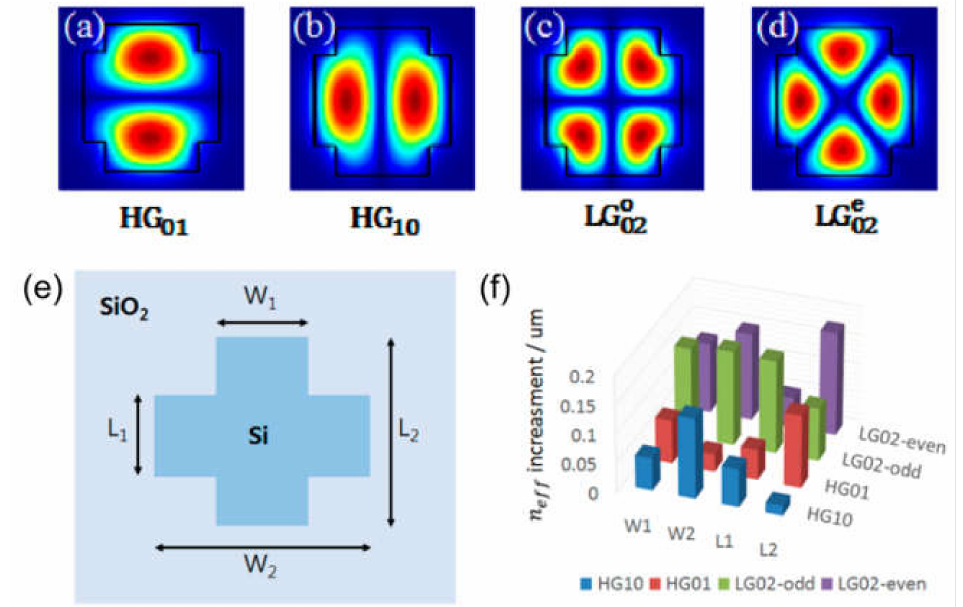
Figure 12. HG-similar mode field allocations in the WG ( a – d ) [163], WG configuration for concur- rently managing l = ± 1 OAM mode and l = ± 2 OAM mode ( e ) [163], mode n eff reliance on WG parameters ( f )